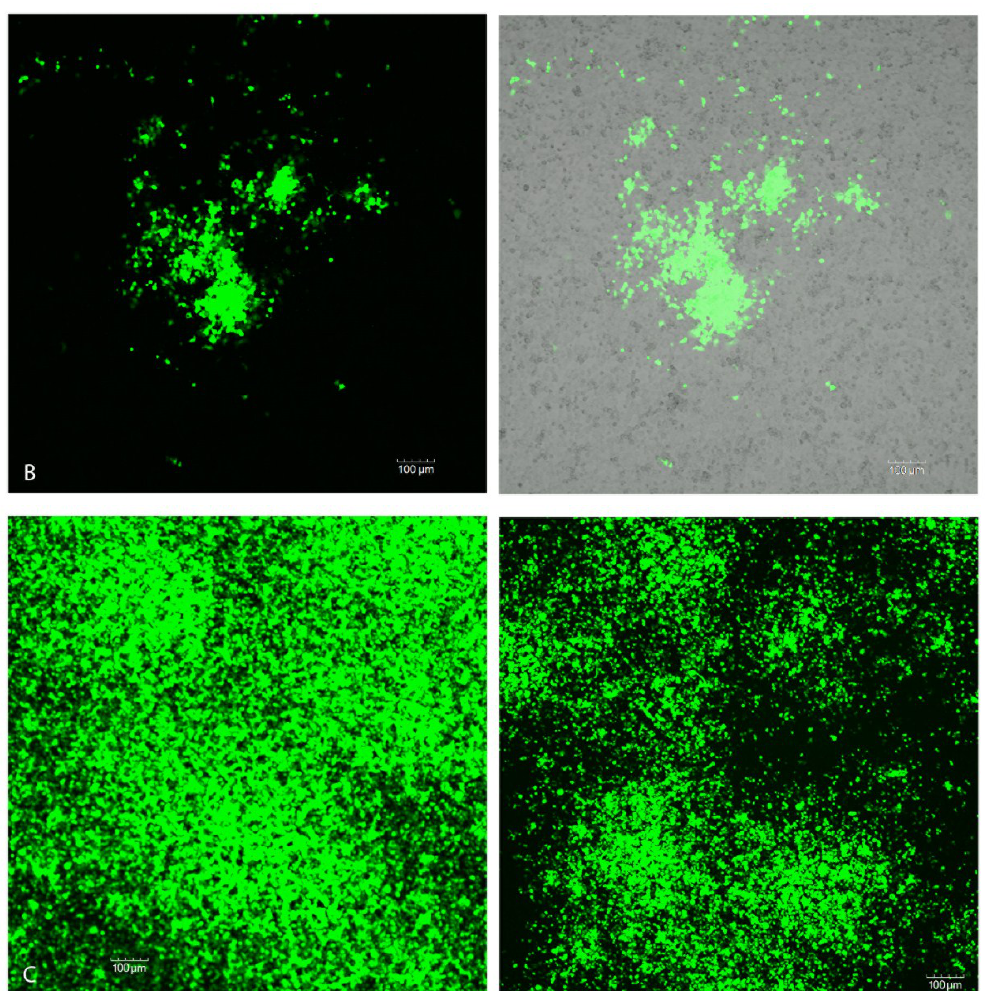
Figure 5. Immunofluorescence confocal microscopy of SINVTaV-GFP-TC infection of C7-10 cells monitored over time in the same culture plates. Composite images; immunofluorescent (left) compared with immunofluorescent merged with phase contrast (right) revealing background monolayer ( A , B ); Plaque growth in cells infected with a M.O.I. of 0.1 in the absence of bLF at ( A ) 24 h p.i. and ( B ) 48 h p.i.; ( C ) Plaque growth in cells infected with a M.O.I. of 100 at 48 h p.i. in the absence (left-image) vs. presence bLF (right-image). Cytopathology and persistence of GFP reporter in the SG proximal lateral (PL) lobe was observed at day 30 p.i. following per os infection of Ae. aegypti with SINVTaV-GFP-TC variant (Figure 6). Both of these persistent virus-associated changes are located in the LL while the ML appears intact. Observation of GFP in the PL suggests retention of virus, retention of the GFP protein or